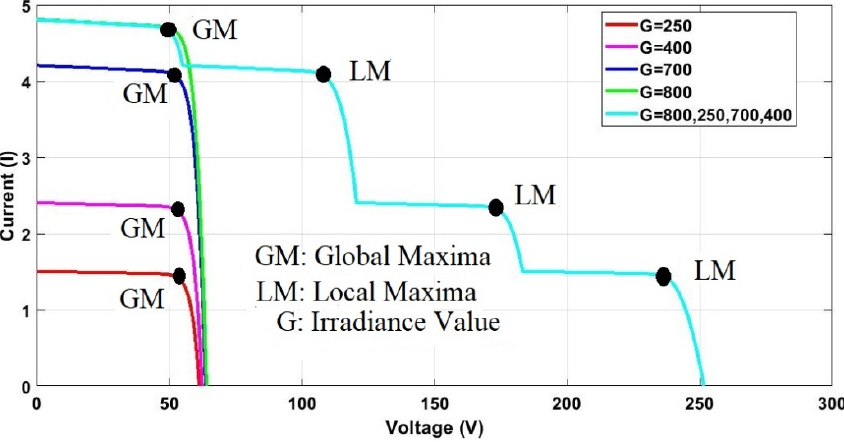
Figure 7. IV curves under PS conditions.